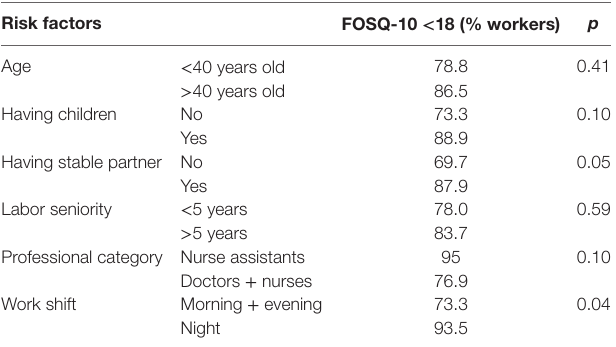
TaBle 2 | Risk factors for bad sleep quality according to Functional Outcomes of Sleep Questionnaire (FOSQ)-10. risk